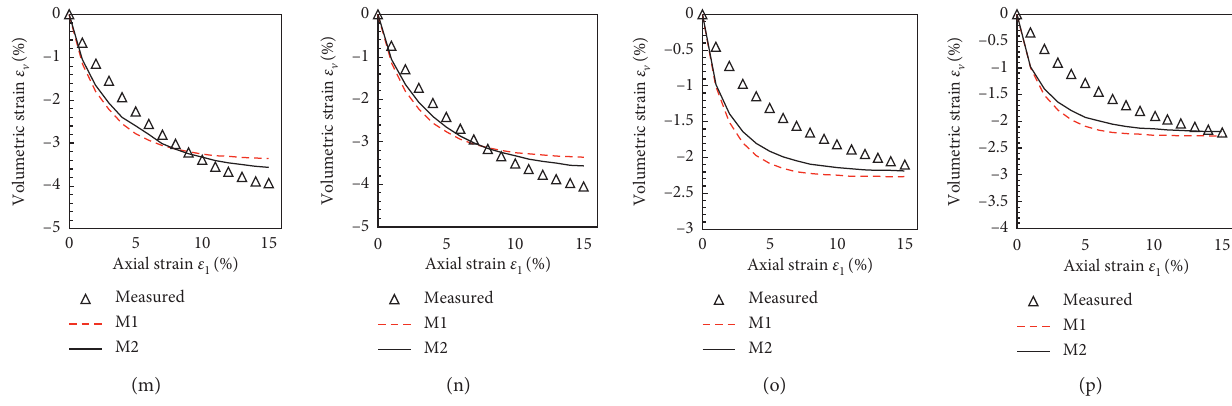
Figure 13: Comparisons between experimental data and the calculated results for the stress-strain curves and volumetric strain-axial strain curves. (a) D r � 0.15, σ 3 � 200 kPa. (b) D r � 0.15, σ 3 � 400kPa. (c) D r � 0.35, σ 3 � 200kPa. (d) D r � 0.35, σ 3 � 400kPa. (e) D r � 0.15,